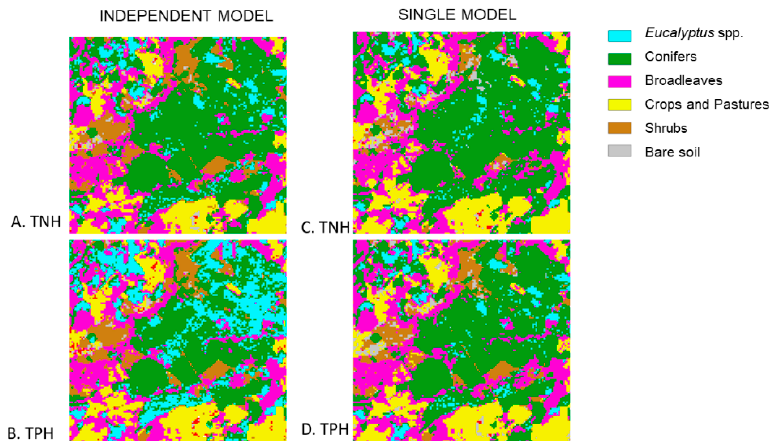
Figure 10. Land cover classification results of contiguous tiles for an overlapping area. ( A – D ) represent the same area. ( A , B ) were obtained using an independent model for each tile. ( A ) represents the results obtained for the TNH tile. ( B ) represents the results obtained for the TPH tile. ( A , B ) are different. ( C , D ) were obtained using one single common model for all of the tiles. ( C ) represents the results obtained for the TNH tile. ( D ) represents the results obtained for the TPH tile. ( C , D ) are quite similar.